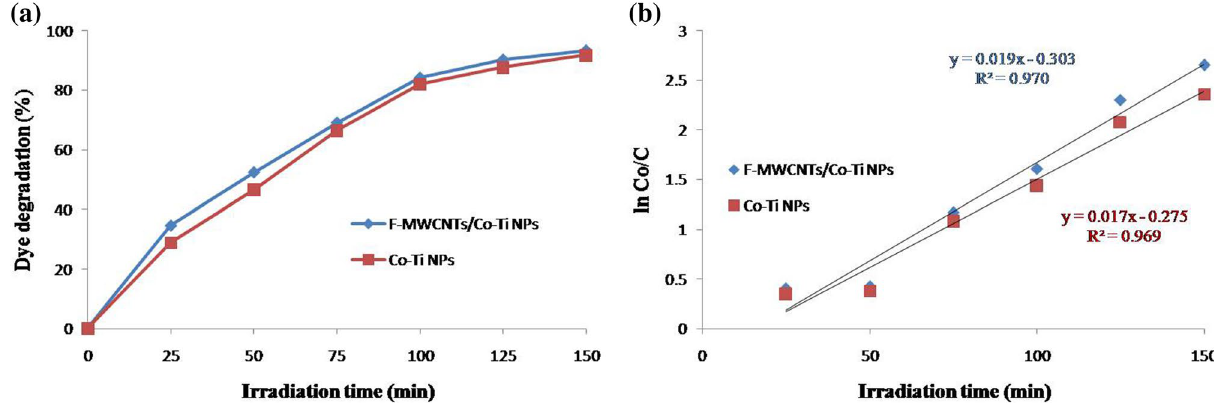
Fig. 6 a Comparison of %degradation of RB dye by F-MWCNTs/Co–Ti oxides and Co–Ti oxide NPs and b kinetics study